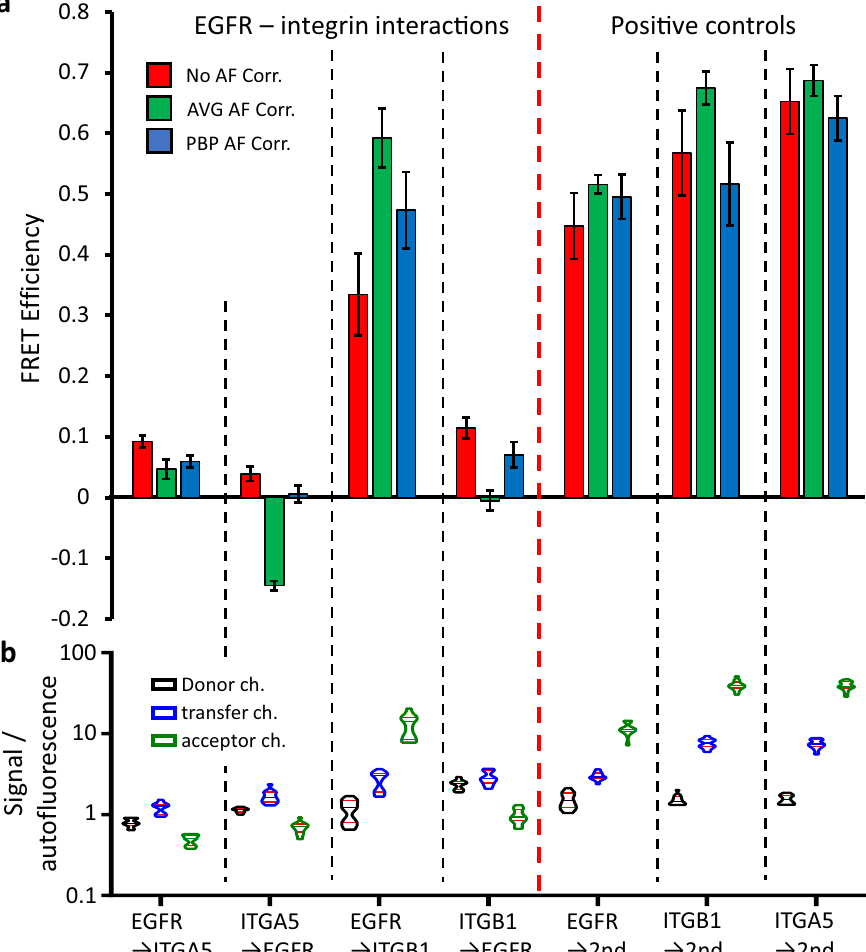
Figure 5. FRET measured with microscopy on adherent cells between biologically relevant molecules and on positive controls. FRET was measured between EGFR and ITGA5 or ITGB1 in both directions, as well as between primary and secondary antibodies bound to each of these molecular targets for positive controls. ( a ) FRET efficiencies calculated with no AF correction, average AF correction and pixel-by-pixel AF correction. Error bars are ± 95% confidence interval from 12 images, each containing a minimum of 5 cells. ( b ) Fluorescence signal relative to autofluorescence in the donor, transfer and acceptor channels, from the samples in ( a ). The means of all images in each category are shown as violin